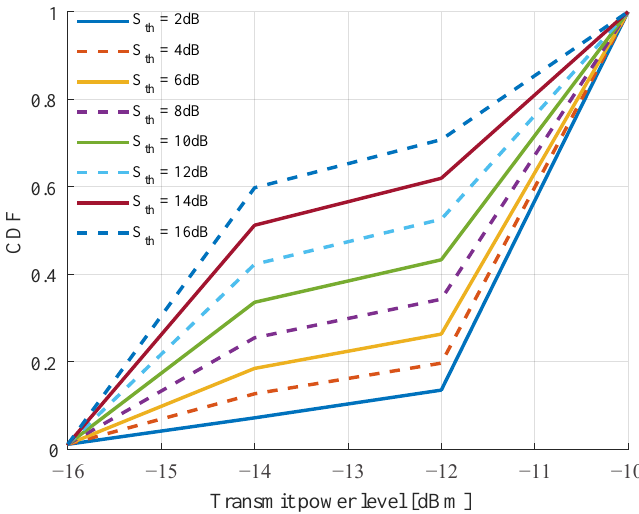
Figure 8. Distribution of selection power by the MAQL method with different s th